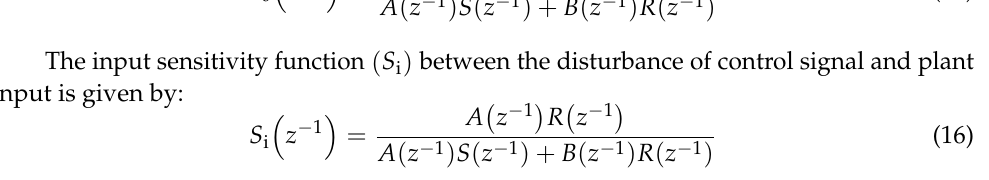
Table 1. Constraints on sensitivity function shapes.